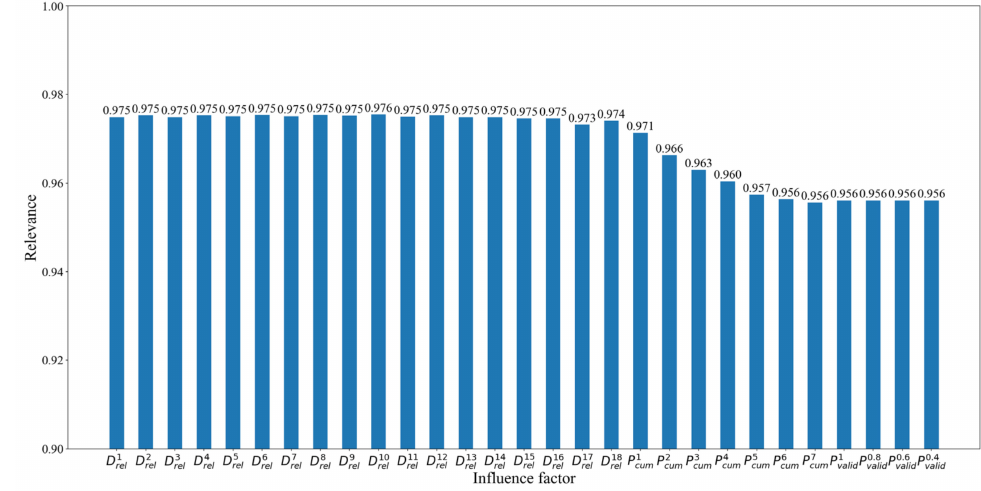
Figure 8. Results of gray correlation analysis for the Zhongma